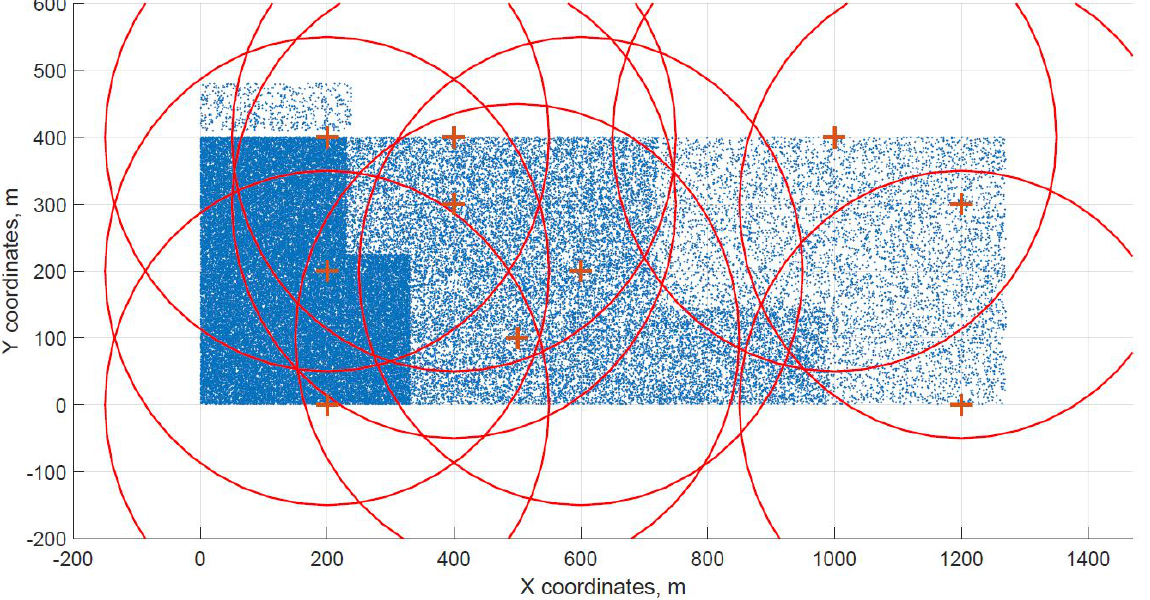
Figure 4. Cuckoo search resulting grid for dataset C.